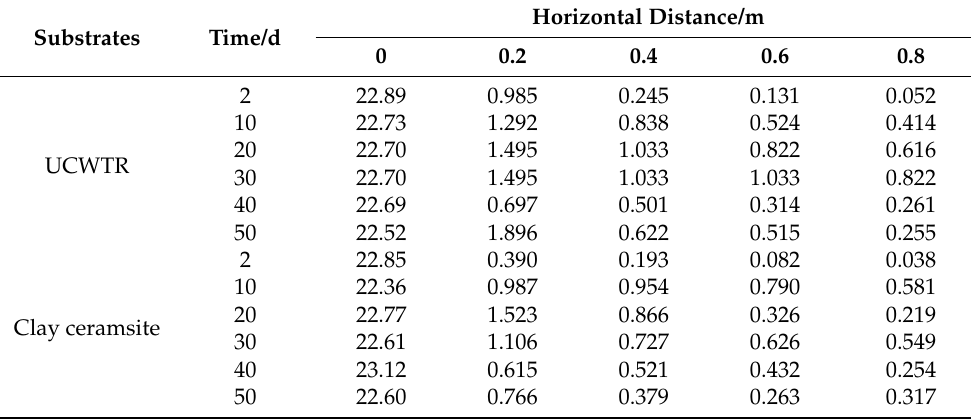
Table 5. Change in horizontal Cu concentration at 2 d, 10 d, 20 d, 30 d, 40 d, 50 d (mg/L).